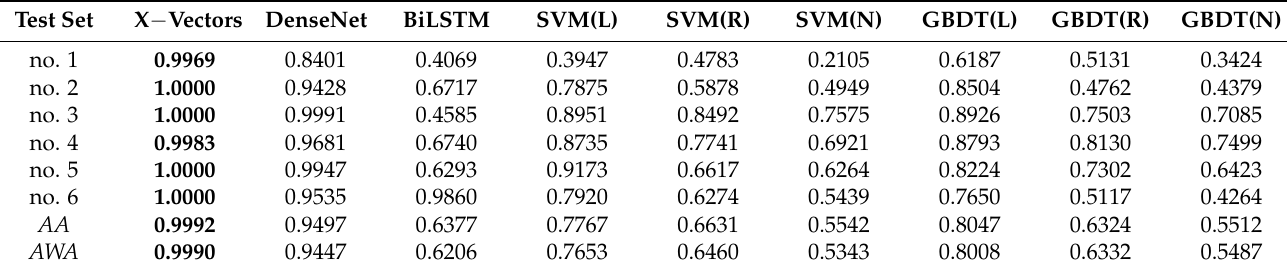
Table 7. Test results of models trained using different